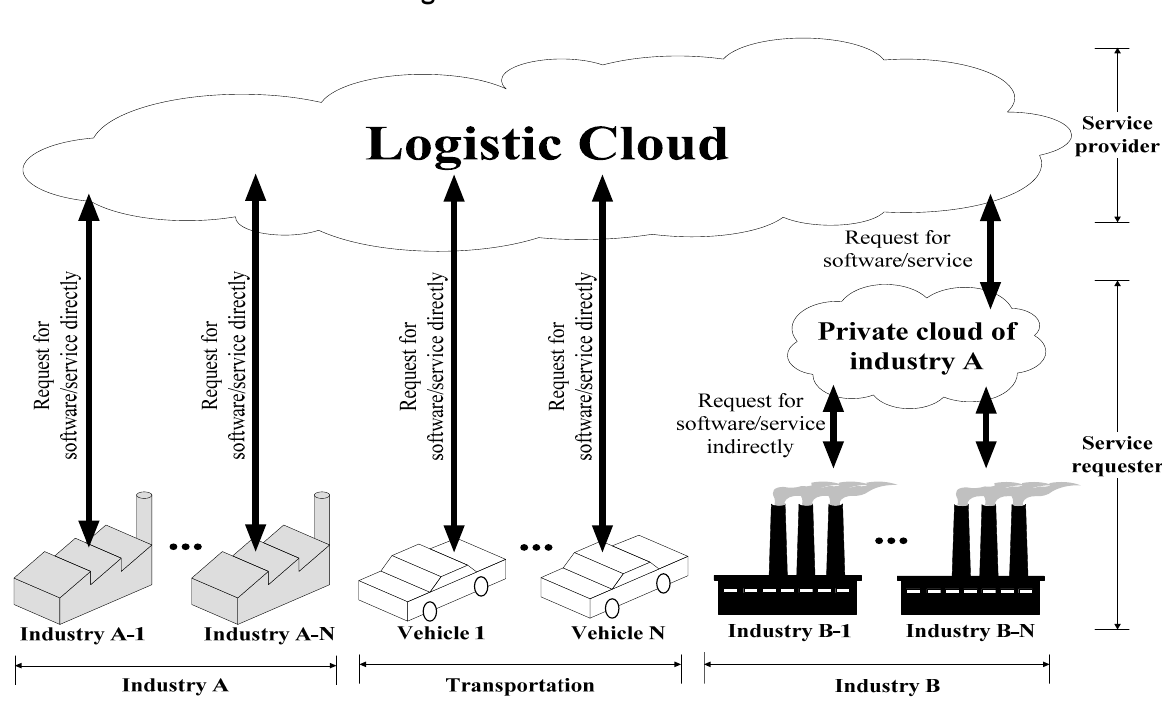
Figure 9. Service access